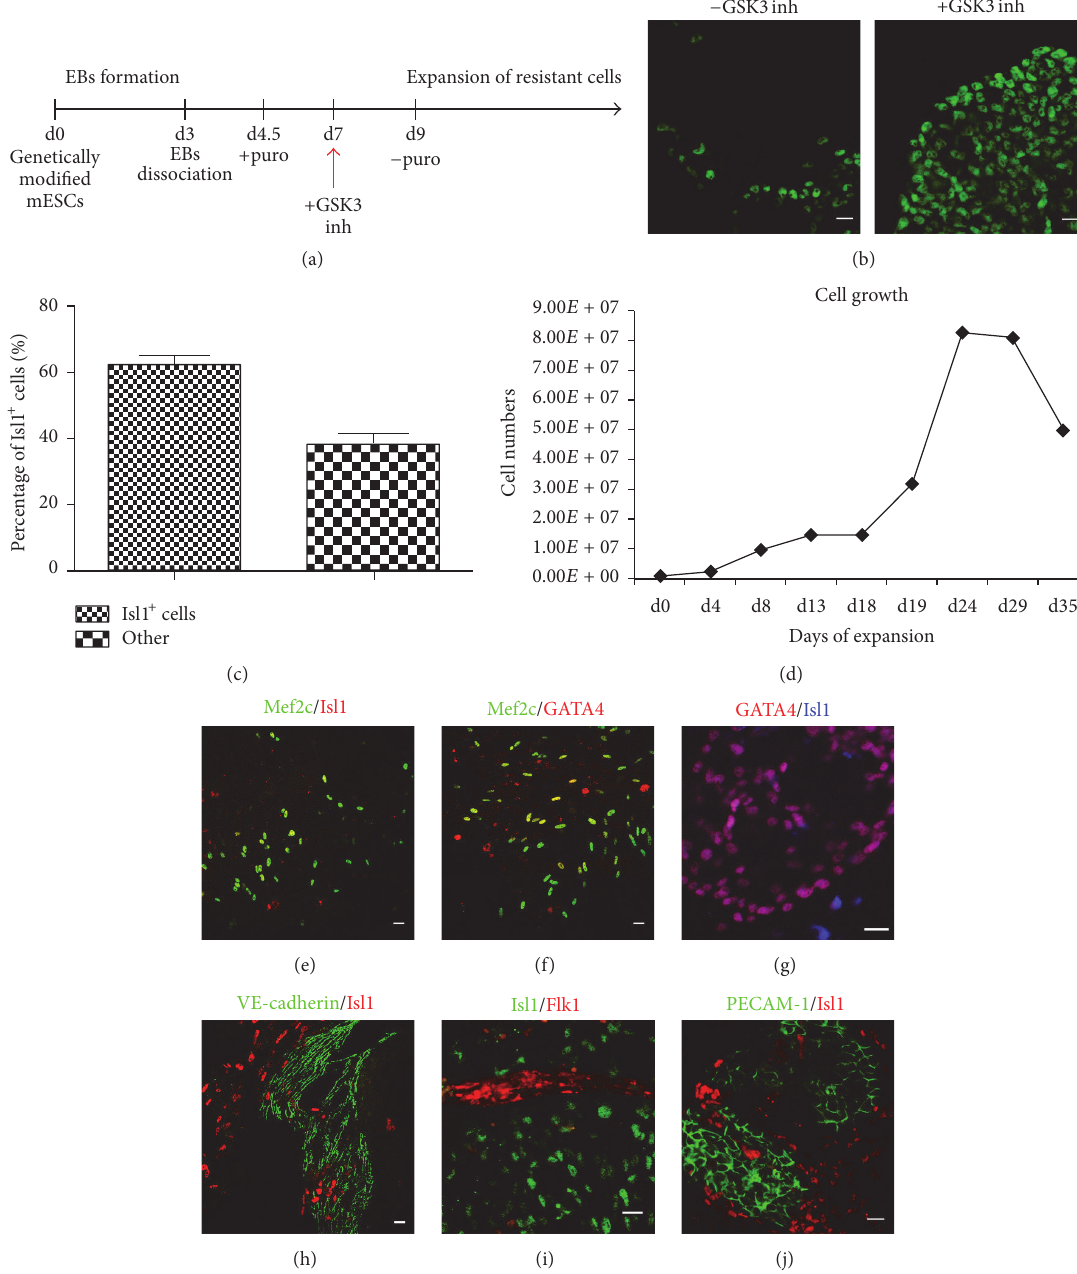
Figure 3: Expansion of Pvec + cells. (a-b) Schematic representation of expansion strategy and propagation of Pvec + cells. Addition of GSK3 inhibitor (SB-216763) induces propagation of Pvec + cells expressing Isl1 at d12. (c) Pvec + /Isl1 + cells percentage in SB-216763 from three independent experiments. For each experiment ∼ 1000 cells were counted. (d) Pvec + cell growth curve. (e–j) Propagated cells consist of cell populations expressing markers of cardiac (Isl1, Mef2c, and GATA4) and/or endothelial (Flk-1, PECAM-1, and VE-cadherin)